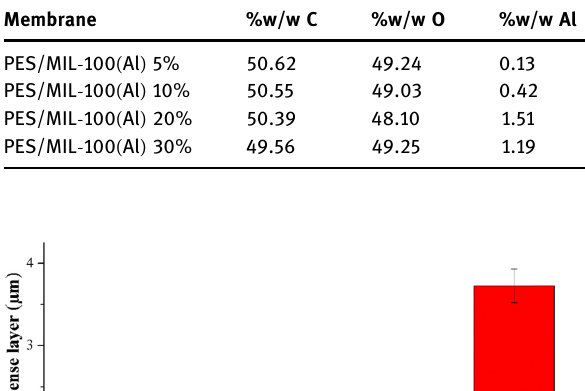
Table 3: Results of the EDX analyses of the PES/MIL - 100 ( Al ) MMMs Membrane